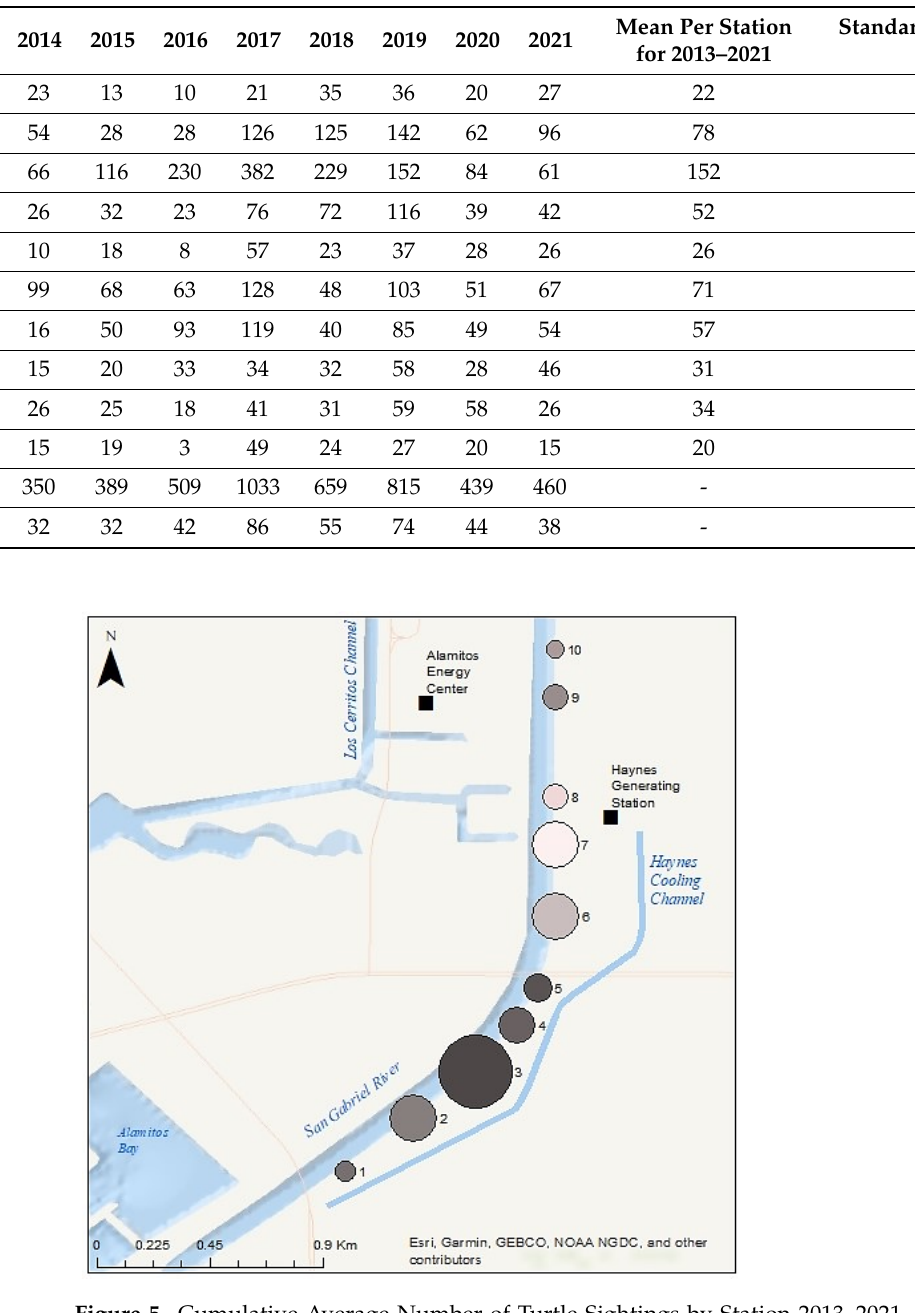
Table 1. Total Sightings per Station by Year, Annual Total Sightings by Year, and Cumulative Means per Station.